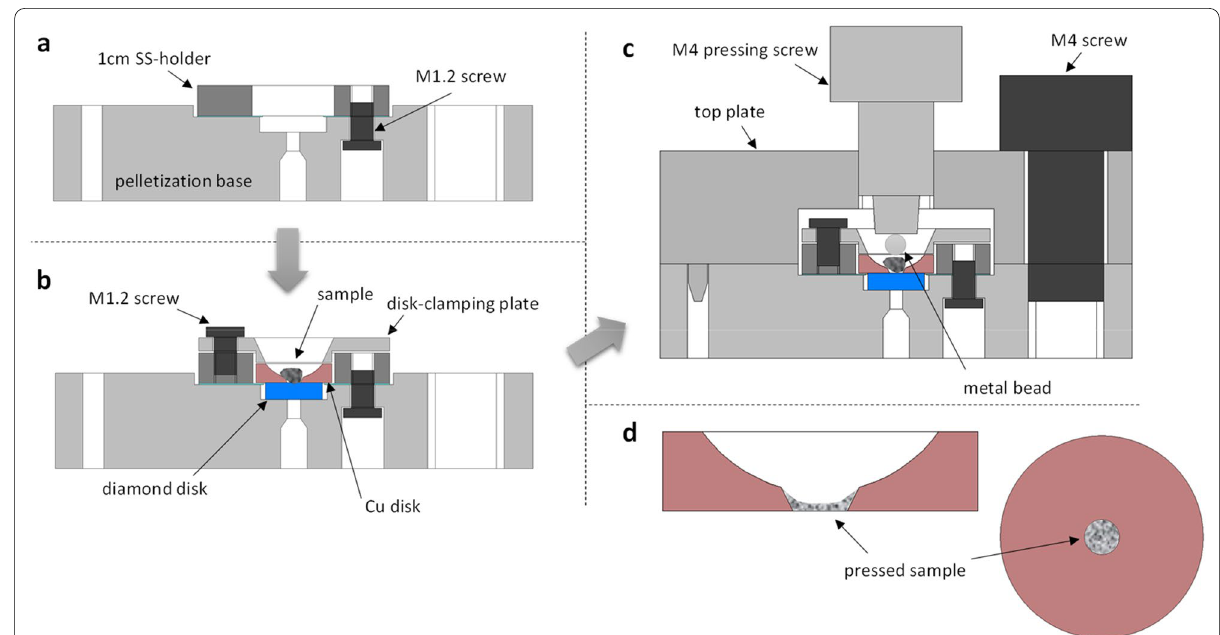
Fig. 4 Schematic diagram of the pelletization operation. a . A stainless-steel holder (shown as 1 cm SS-holder) was installed on the pelletization base and fixed using M1.2 (φ1.2) screws. b . The diamond and Cu disks were set on the pelletization base and fixed using the disk-clamping plate and M1.2 screws. A sample was placed against the Cu disk. c . The top plate was fixed using M4 screws. The sample was pressed against the diamond disk with a metal bead using the M4 pressing screw. d . Schematic diagram of the Cu disk holding the pelletized